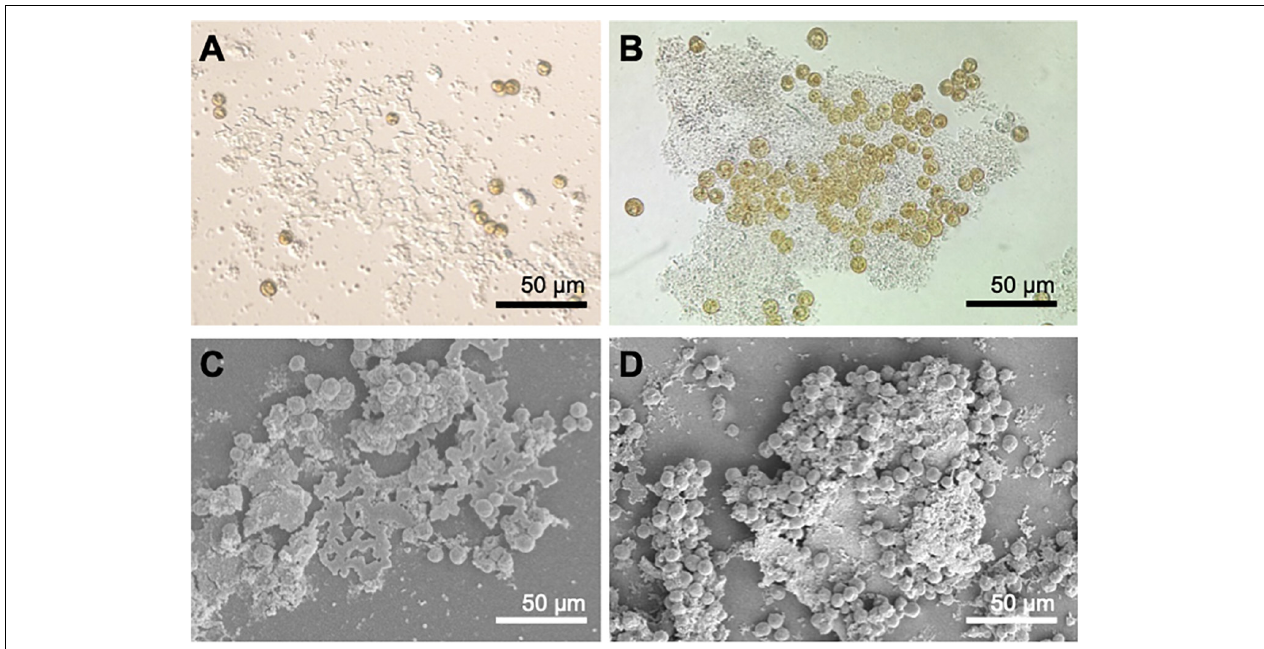
FIGURE 6 | Differential Interference Contrast (DIC) microscopy (A) , light microscopy (B) and SEM images (C,D) of calcifying matrix biofilm in Symbiodiniaceae cultures.